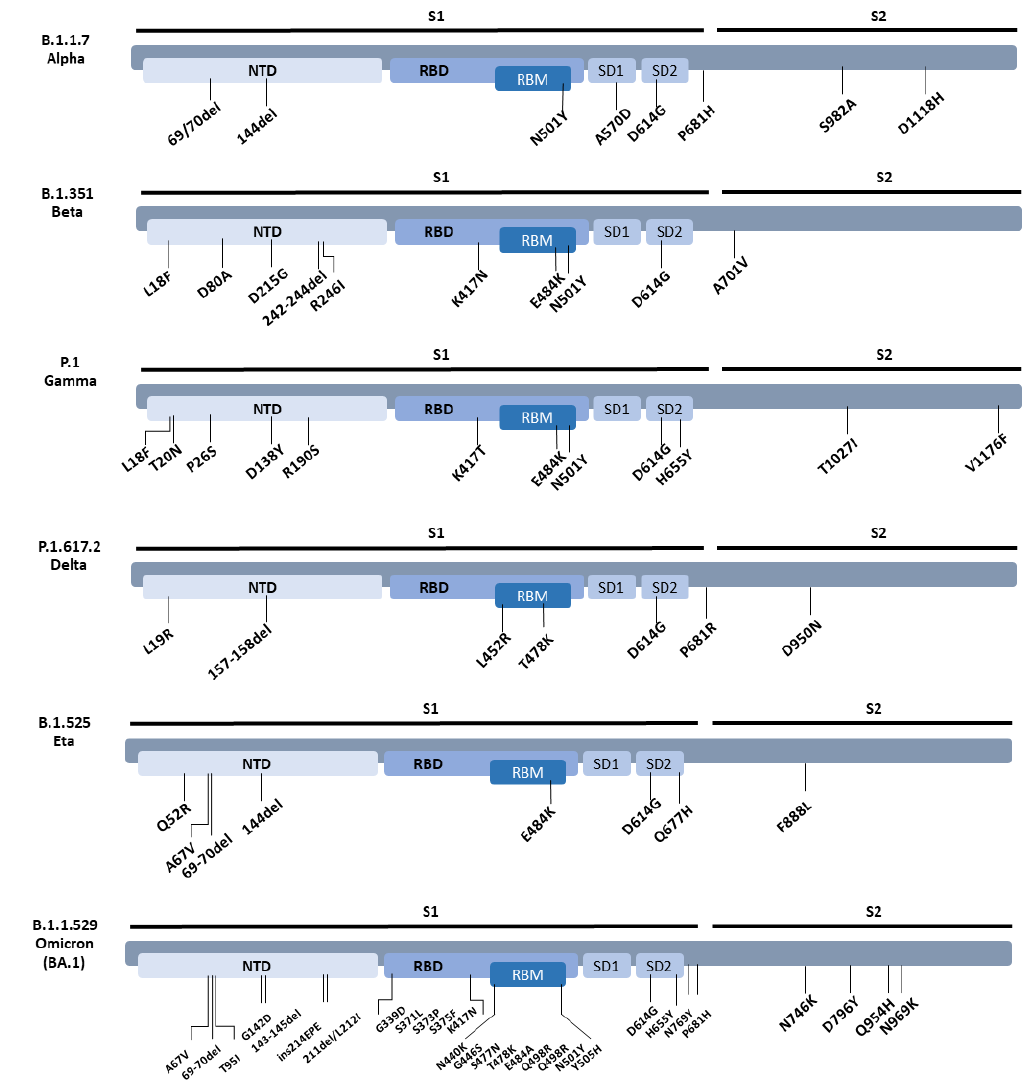
Figure 2. SARS-CoV-2 variants spike mutations used in this